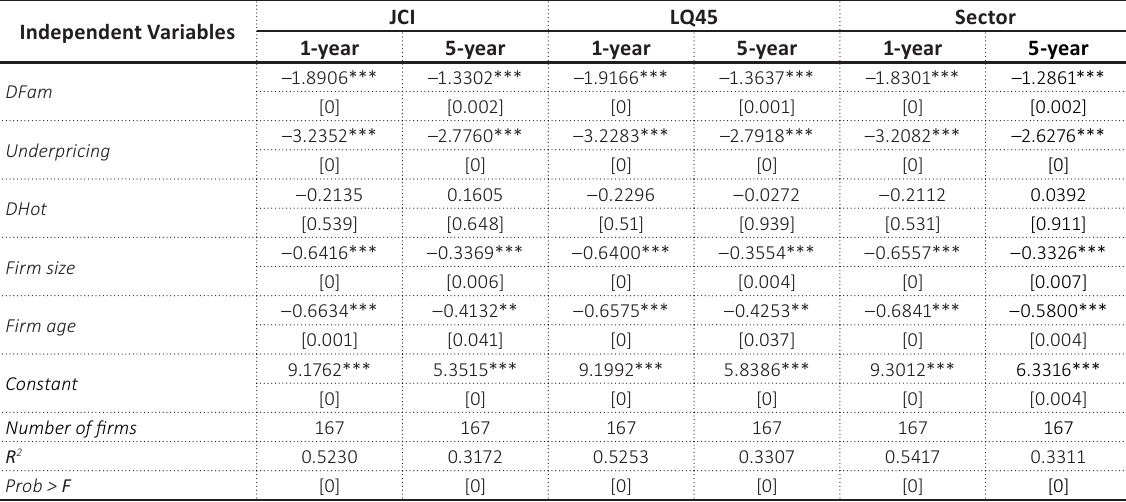
Table 6. Effect of family ownership on IPO long-run performance Independent Variables